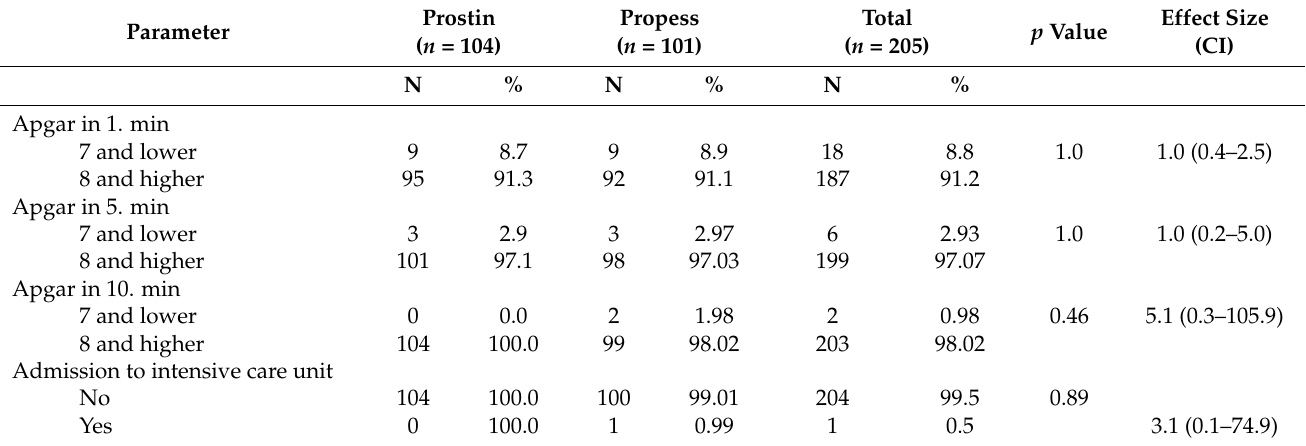
Table 5. Neonatal data of the study population according to the study groups. N—number of cases, %—percentage of the group., CI—confidence